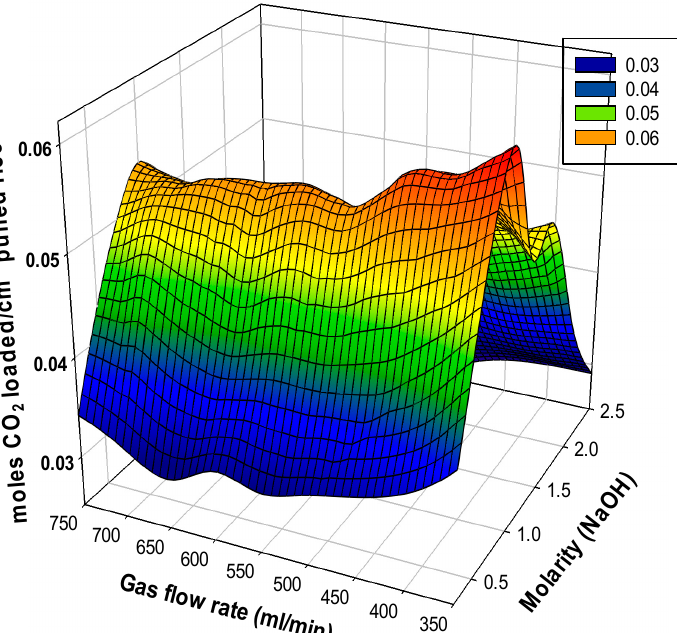
Figure 13. 3D plot showing the effect of NaOH solution molarity and gas flow rate (mL/min) on the CO 2 moles loaded per unit surface area of the puffed rice cake using the MSPRC model.